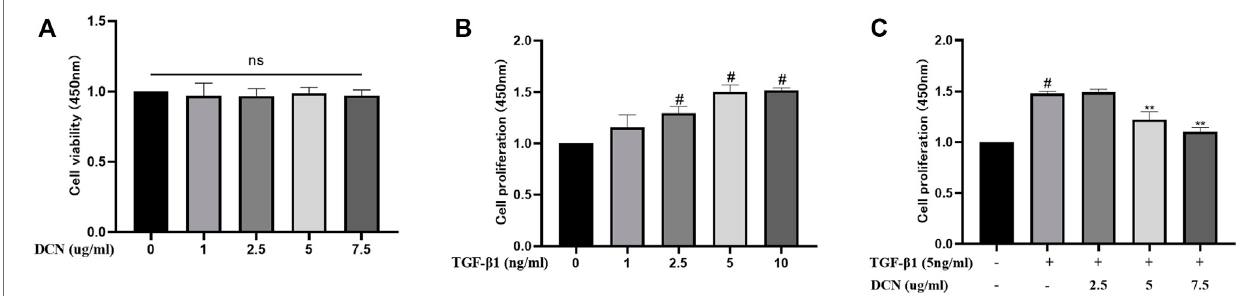
FIGURE1| Effects ofdecorin(DCN)oncellviabilityandTGF- β 1-induced proliferationareevaluatedusingaCCK-8 kit.Theabsorbanceofthecellsat 450 nmfrom each group is detected and recorded. (A) Fibroblasts were exposed to DCN (1, 2.5, 5, and 7.5 µg/ml) or (B) TGF- β 1 (1, 2.5, 5, and 10 ng/ml) for 48 h. (C) Fibroblasts were treated with TGF- β 1 (5 ng/ml) with or without DCN (2.5, 5, and 7.5 µg/ml) for 48 h. ns indicates no signi fi cance. # p < 0.05 vs control group; ** p < 0.01 vs TGF- β 1 group.